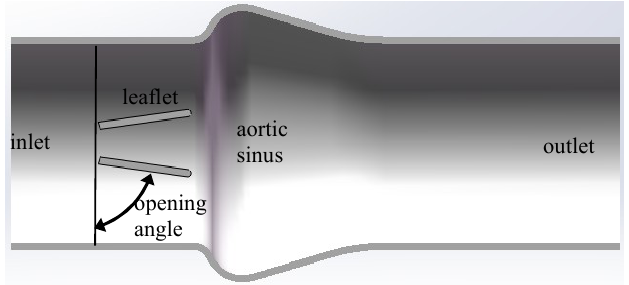
Figure 1. The perpendicular cut-plane view of the three-dimensional bileaflet mechanical heart valve (BMHV) geometry.